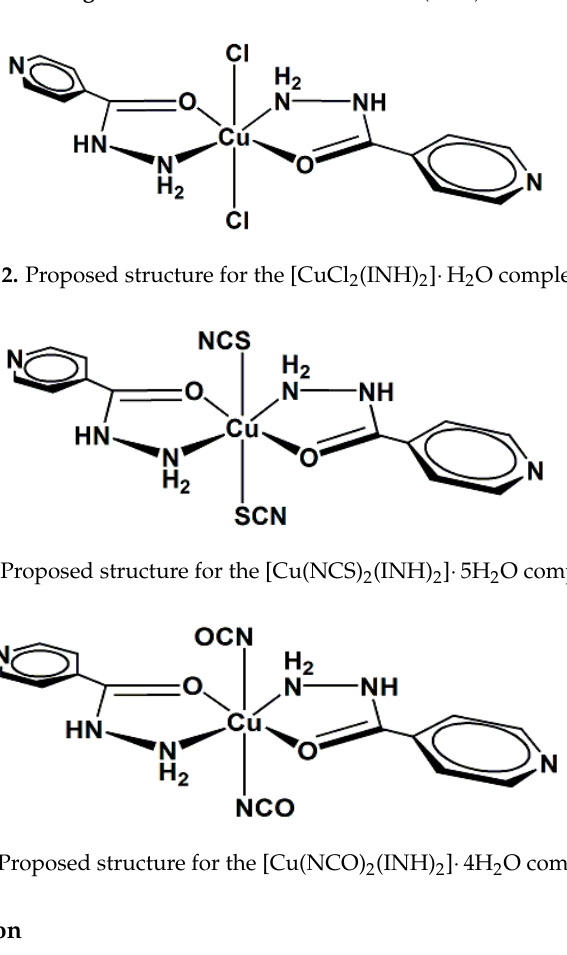
Figure 1. Structure for the isoniazid (INH). Molecules 2015 , 20 , page–page